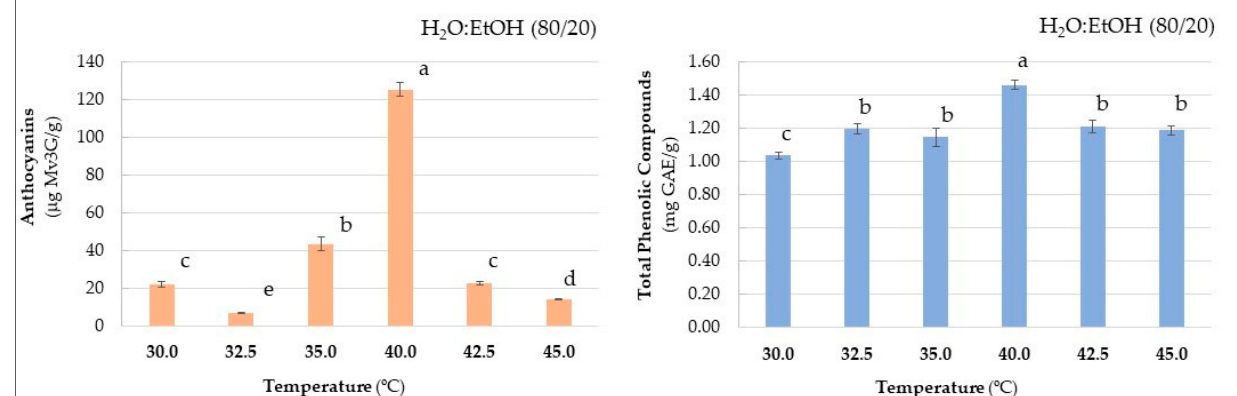
Figure 4. Content of anthocyanins and total phenolic compounds over a range of temperatures from 30 °C to 45 °C. Bars with the same letter are not statistically different (ANOVA with Tukey post hoc test, level of significance p < 0.05).